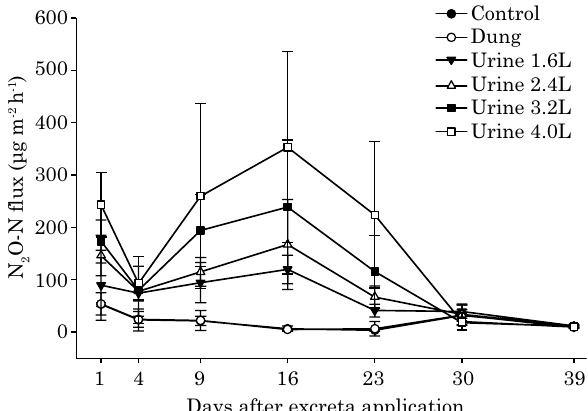
figure 2. N 2 O-N fluxes after sheep urine and dung application in a subtropical Argissolo Vermelho Distrófico típico (typic Paleudult) under italian ryegrass pasture. urine was applied at four rates (1.6, 2.4, 3.2, and 4.0 l m -2 ), with 2.4 l m -2 being the mean volume per urination. dung was applied at a rate of 0.135 kg m -2 of dry matter, which is twice the mean weight per defecation. Bars represent the standard